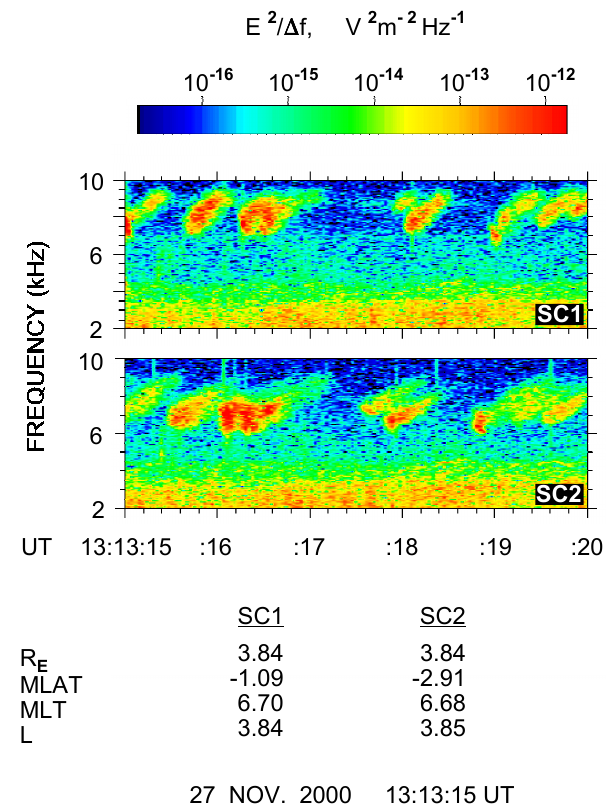
Fig. 5. Expanded time scale spectrograms of the chorus emis- sions in Fig. 4 starting at 13:13:15UT, slightly south of the mag- netic equator. The spacecraft coordinates are given at the bottom of the plot for 13:13:15UT. Note the excellent correlation between the chorus